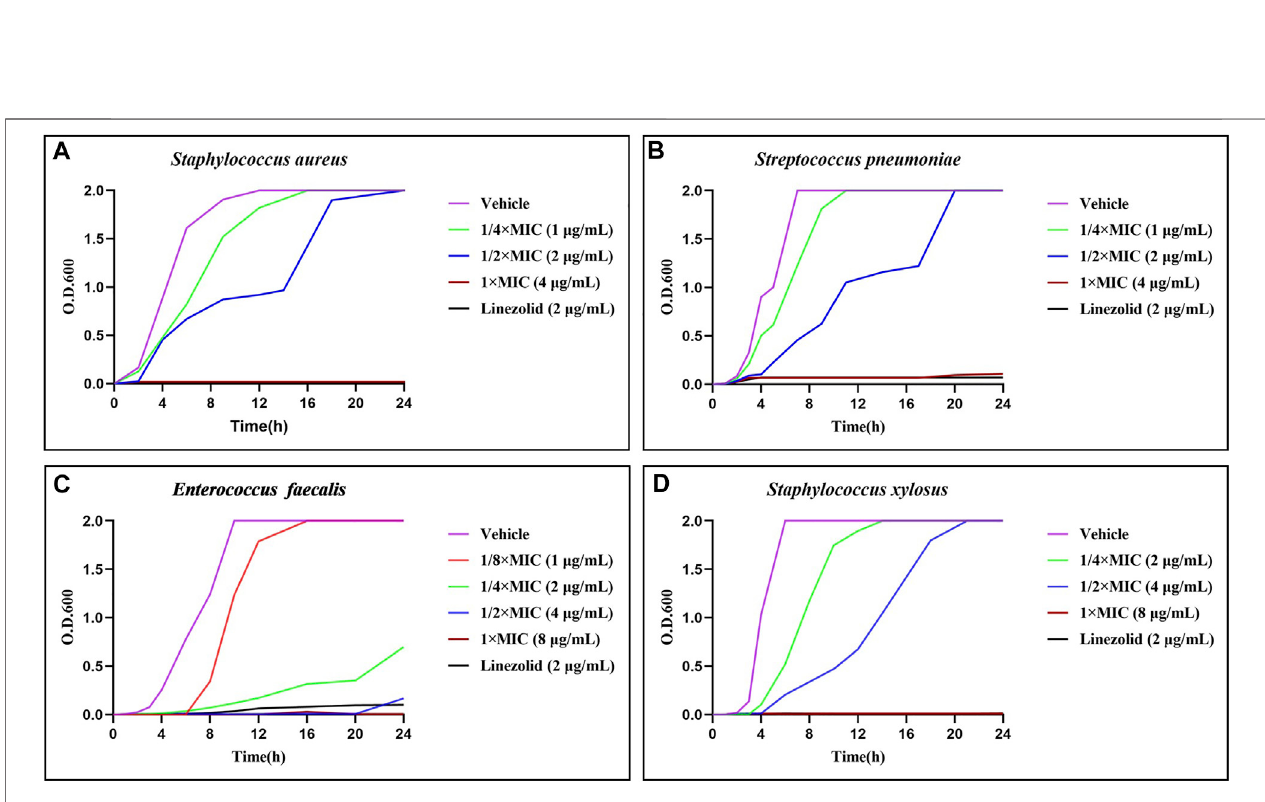
FIGURE 4 | Time-growth kinetics for the compound 21d and linezolid (1/2 × MIC) against S. aureus (A) , S. pneumoniae (B) , E. faecalis (C) and S. xylosus (D) within 24 h.